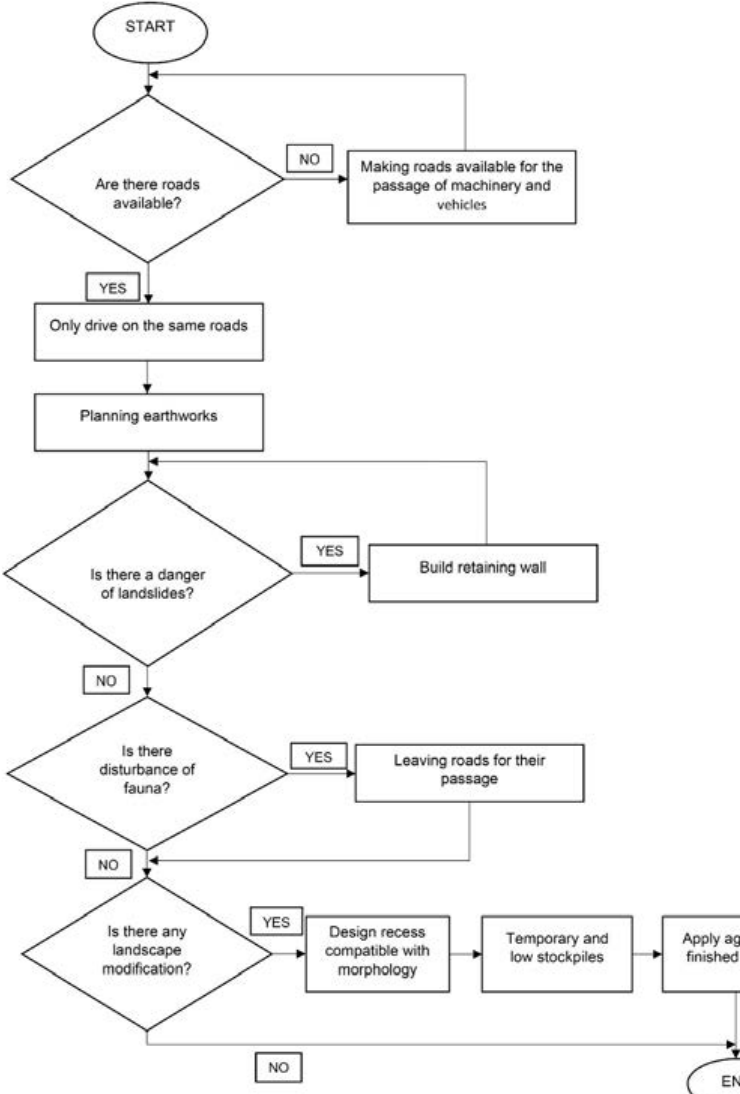
Fig. 9: Flow chart to improve disturbed areas in mining and reduce the impact on landscape, fauna and flora